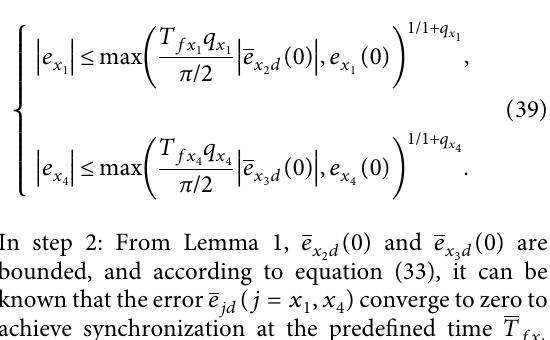
Figure 22: Te system control input. (a) u